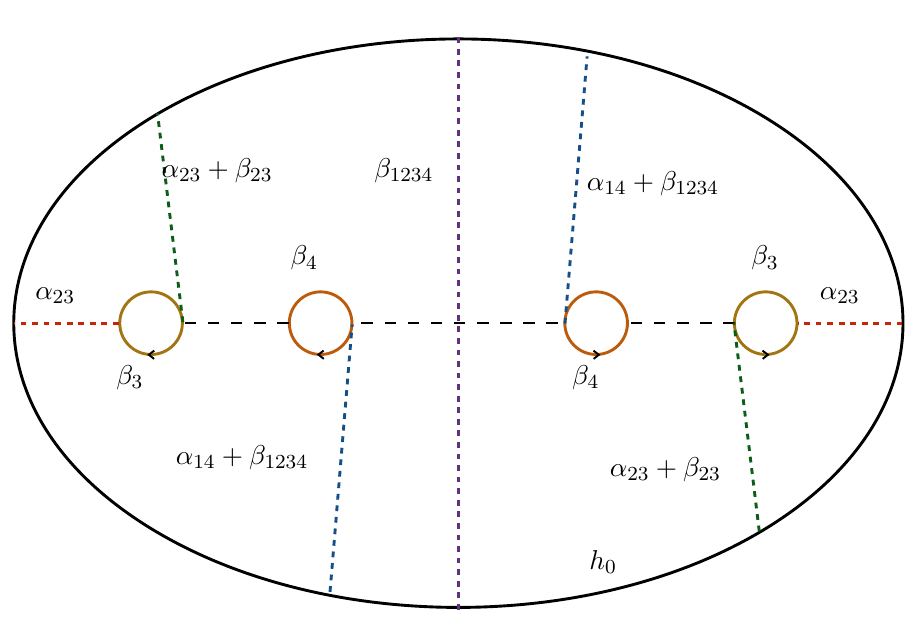
(a) One half of the (cid:13)attened Riemann surface. The surface has been cut along the cycles (cid:12) 3 and (cid:12) 4 along the (cid:12)xed point set of re(cid:13)ection across the vertical purple dashed line.